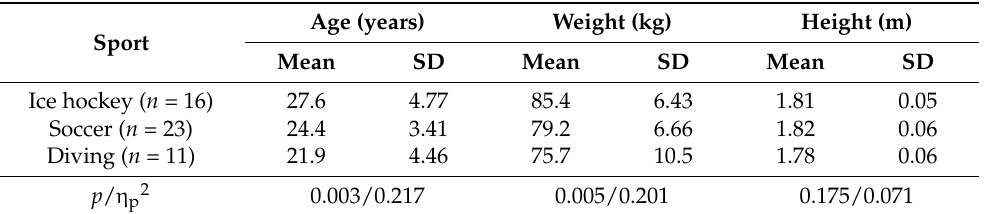
Table 1. Anthropometric subject data (mean ± standard deviation (SD)) by sport. Significant differences between sports ( η p2 > 0.10) are indicated in